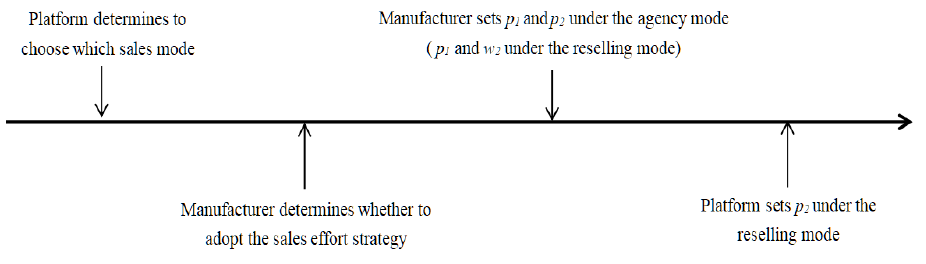
Figure 1. The game